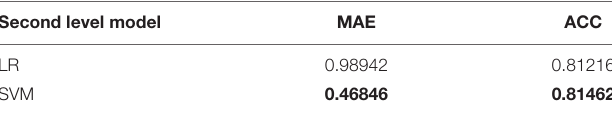
TABLE 7 | Stacking model